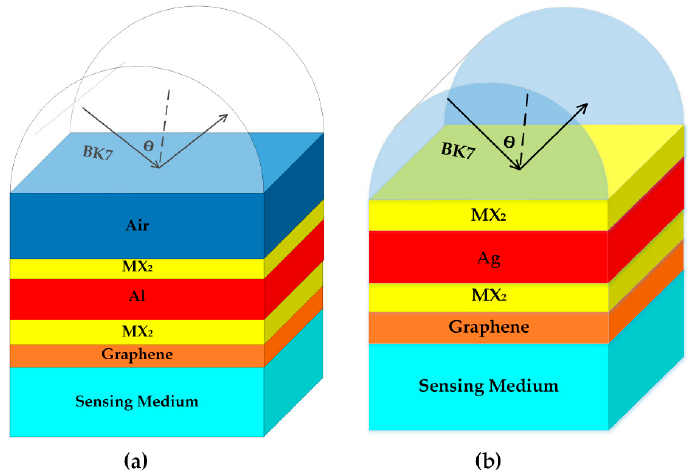
Figure 1. Schematic diagram of the SPR biosensor for ( a ) angle-sensitivity enhancement and ( b ) phase- sensitivity enhancement.